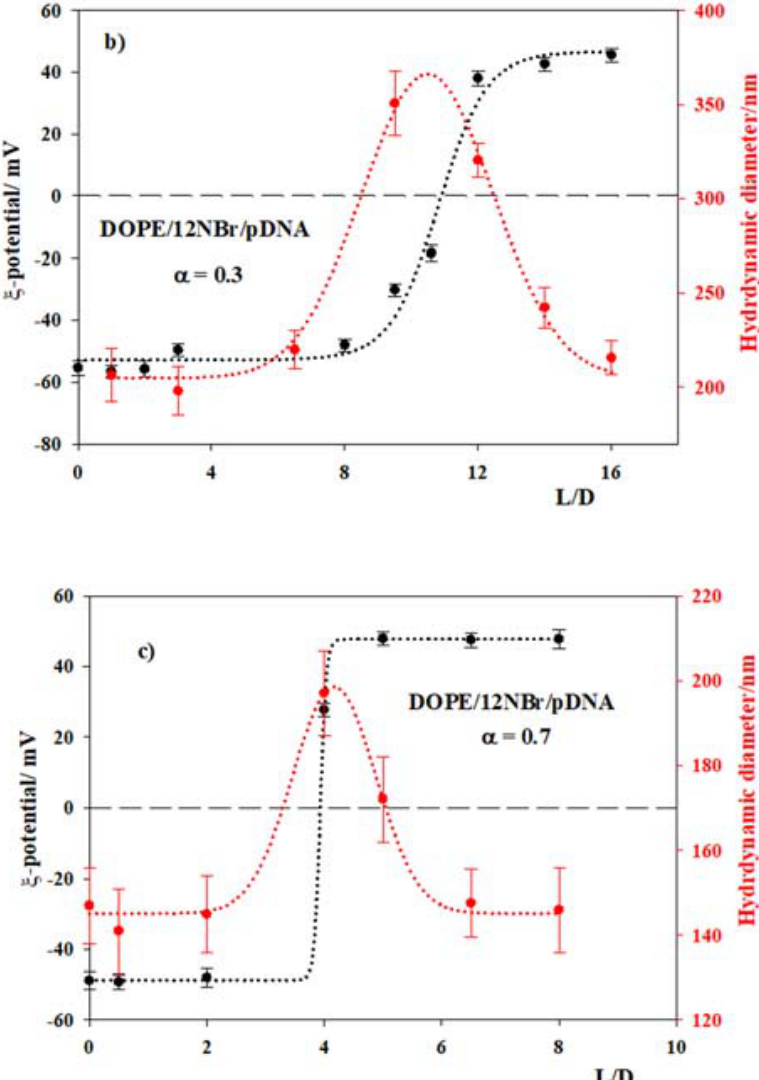
Figure 5. Dependence of the zeta potential and of the hydrodynamic diameter of DOPE/12NBr/pDNA liposomes on the mass ratio, L/D, for various cationic surfactant molar fractions, α , in 10 mM HEPES (pH = 7.4) at T = 303.0 ± 0.1 K. ( a ) α = 0.2, ( b ) α = 0.3 and ( c ) α = 0.7. One can see that an increase in the cationic surfactant molar fraction α resulted in the migration of pDNA being hindered at lower L/D values. That is, the nucleic acid was neutral or positively charged at at lower L/D values the higher α is. In order to investigate if the formation of the DOPE/12NBr/pDNA lipoplexes was accompanied by a morphological change of the pDNA, CD spectra were registered for various α at different L/D values. Figure 7 shows that the changes in the pDNA CD spectra depend on α . For L/D = 0, that is, when no cationic surfactant was present, the typical CD spectrum of a right-handed B form of a double stranded nucleic acid was observed [59]. For α = 0.2, a displacement of the bands to longer wavelengths, a small increase in the intensity of the negative band and a strong decrease in the intensity of the positive band were observed for L/D < 5. At high L/D values, 18 and 20, both bands practically disappeared. In the case of α = 0.3 a shift of the bands to longer wavelengths was observed, together with a strong decrease of the positive and negative bands. Finally, for α = 0.7, for all the L/D values investigated, similar observations to those for α = 0.2 at high L/D values were found, although the intensity of the negative band